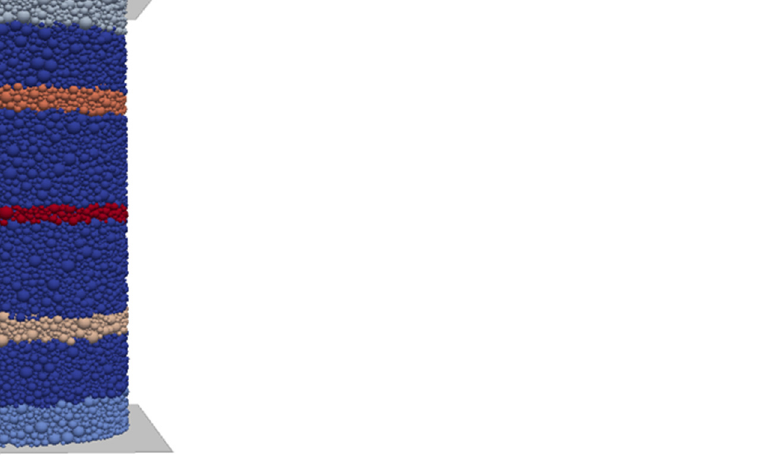
Figure A1. A typical DEM specimen employed for uniaxial compression calibration simulations.